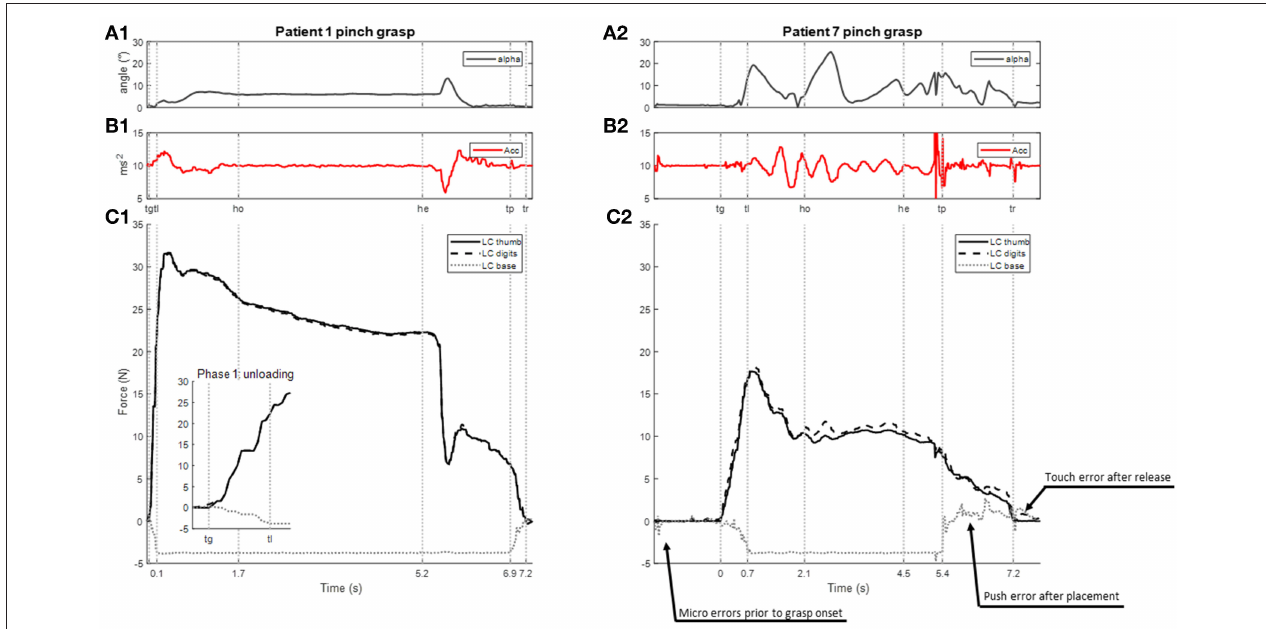
FIGURE 3 | Examples of recording of a lifting task carried out with the hemiparetic arm using the pinch grip in two patients with contrasting functional abilities (P1, FME 66 and P7 FME 37; see Table 1 for details). From top to bottom: (A1,2) angle measuring the deviation of the iBox from the vertical (B1,2) vertical acceleration of the iBox (C1,2) force signals: grasping force is indicated with plain (thumb) and dashed lines (digits), the unloading of the bottom face of the object is indicated with (dotted lines); inset in (C1) shows a larger scale. Vertical lines indicate the times of transitions between phases tg = onset of grip; tl = onset of lifting; ho = hold onset; he = hold end; tp = placement time; tr = release time. Time = 0s at tg . In (C2) , arrows indicate touch and push errors upon establishing and releasing